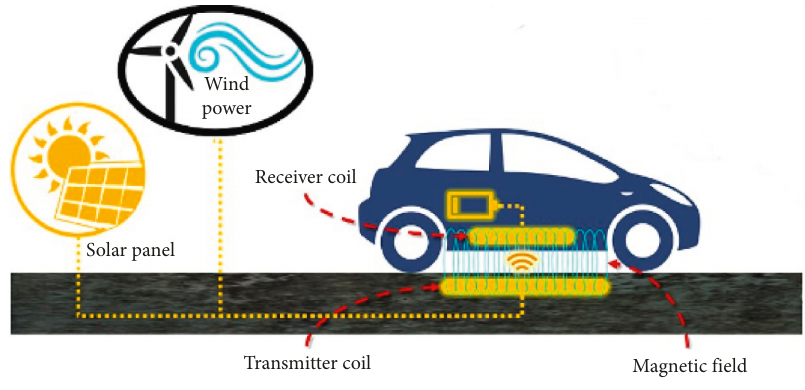
Figure 24: Wireless charging. Table 5: Levels of EV